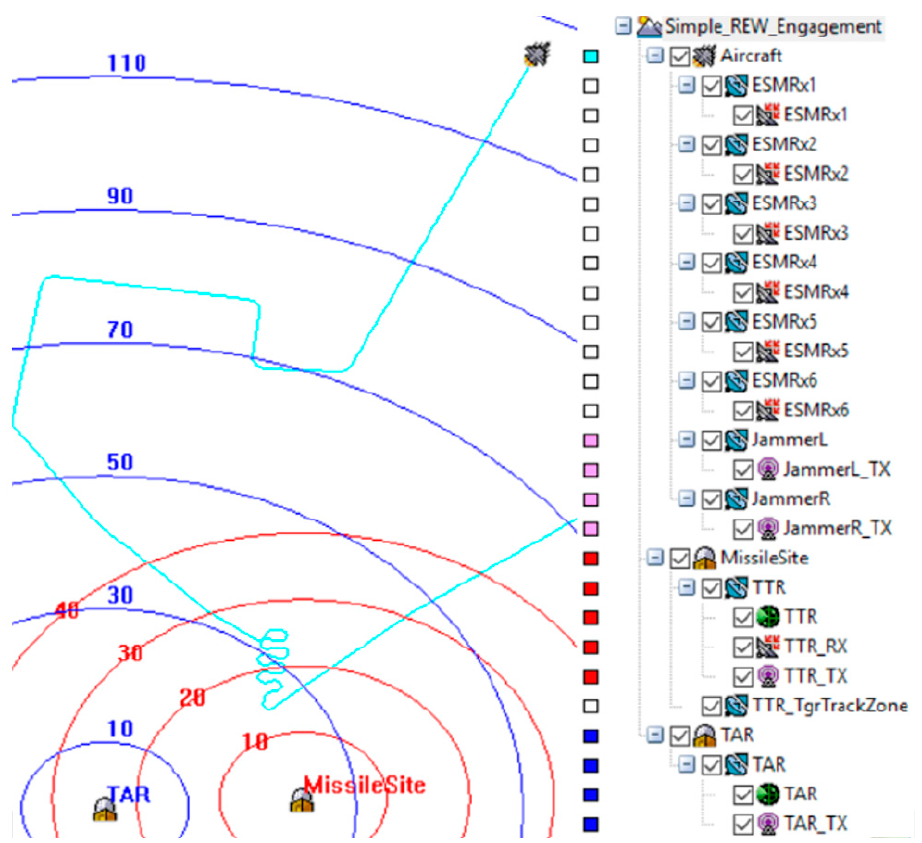
Figure 7. Top view of the beginning of the simple REW engagement scenario, the blue and red circles indicate the ranges from radar centers in kilometers and the hierarchy of STK models (TAR: target acquisition radar, TTR: target tracking radar).